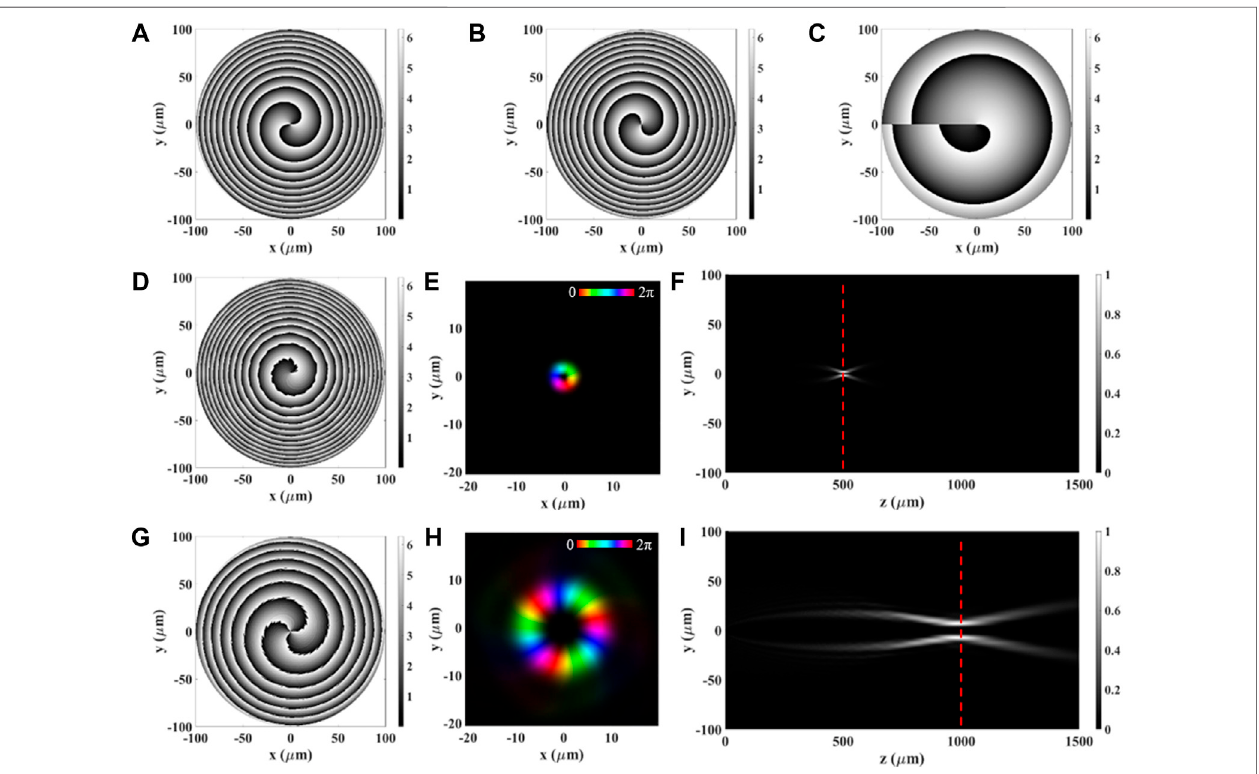
FIGURE 5 | Simulations of DFML implementing Eqs 16 , 17 . (A – C) ML design phase maps of δ x (A) , δ y (B) , and θ (C) from Eqs 7 – 9 . (D,G) show ϕ + and ϕ − phase maps, respectively. (E) Intensity and phase of the propagated fi eld under LCP polarization at z = 500 µm. (F) Intensity cross-section ( yz -plane, from 0 to 1.5 mm, x = 0) underLCPpolarization. (H) Intensityandphaseofthepropagated fi eldunderRCPpolarizationat z (cid:2) 1000µm. (I) Intensitycross-section( yz -planefrom0to1.5 mm ,x = 0) under RCP polarization. In (E,F) , brightness and colours refer to intensity and phase, respectively.